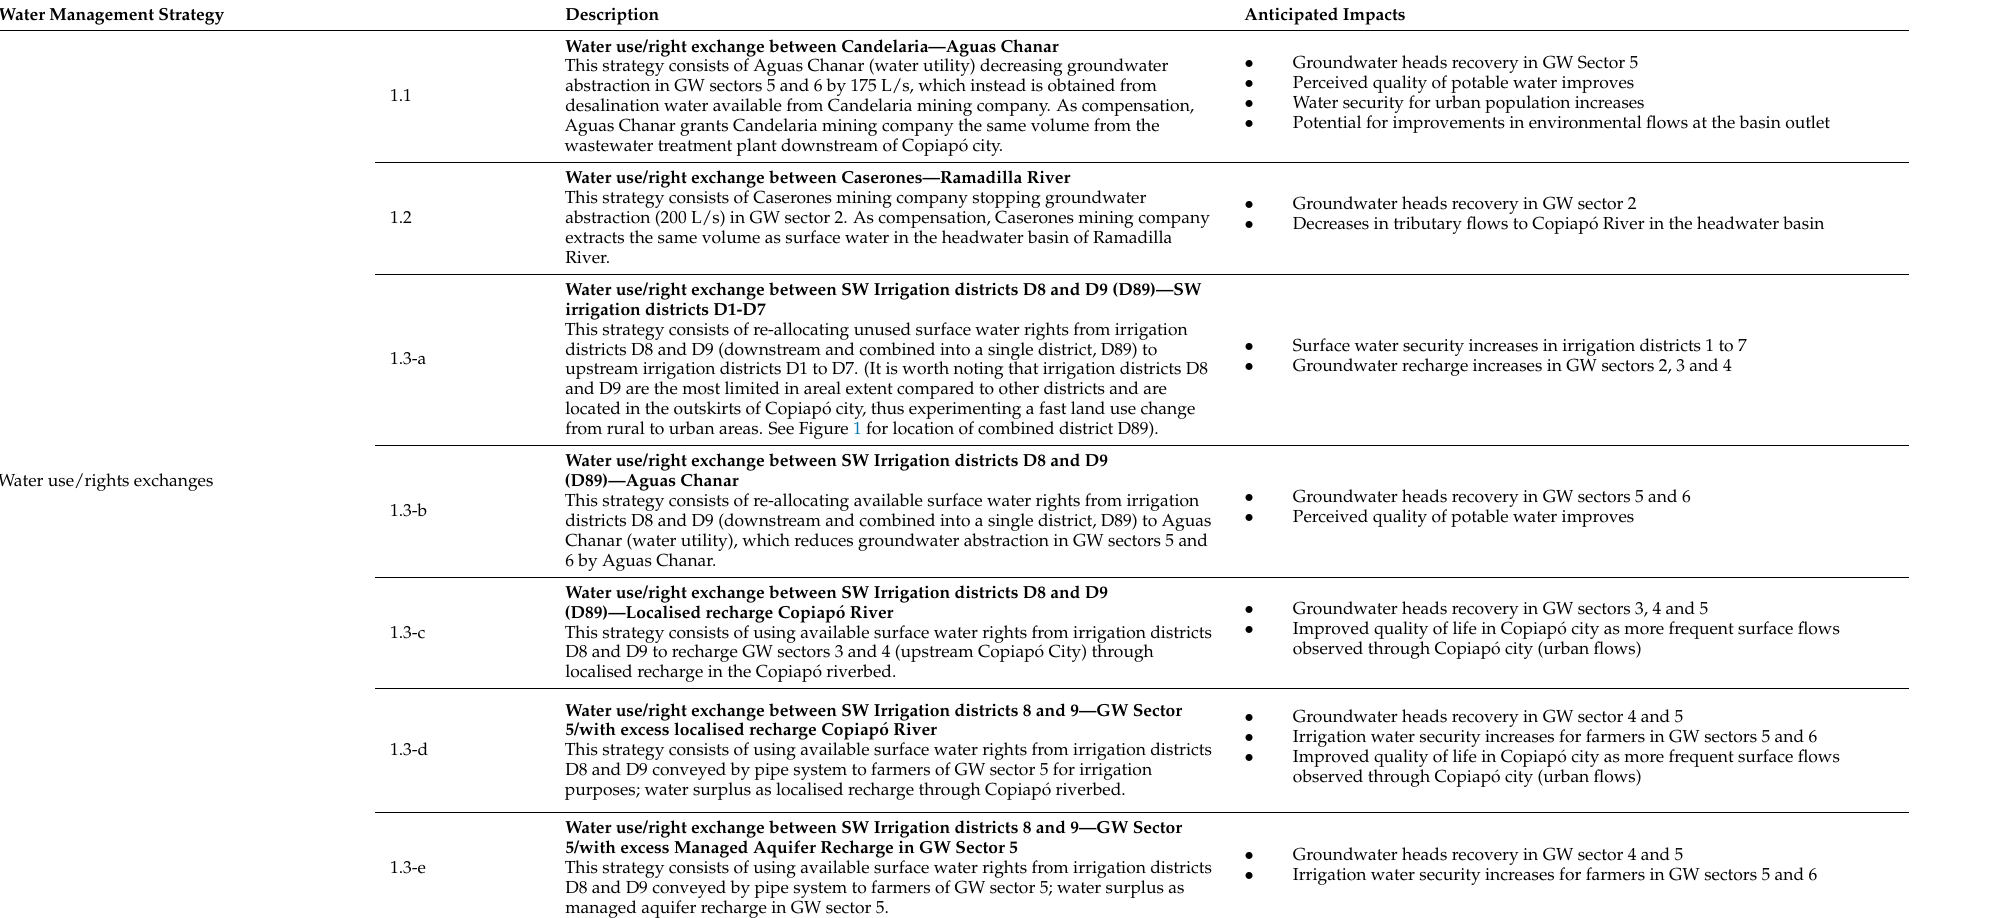
Table 1. Water management strategies devised through the participatory process with main stakeholders in the Copiap ó River